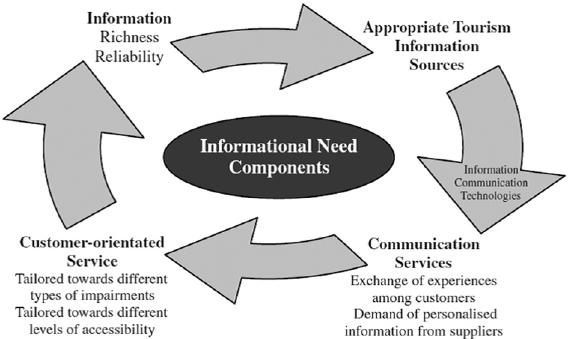
Fig. 2. Components of interrelated needs. Source: Eichhorn et al. (2008: